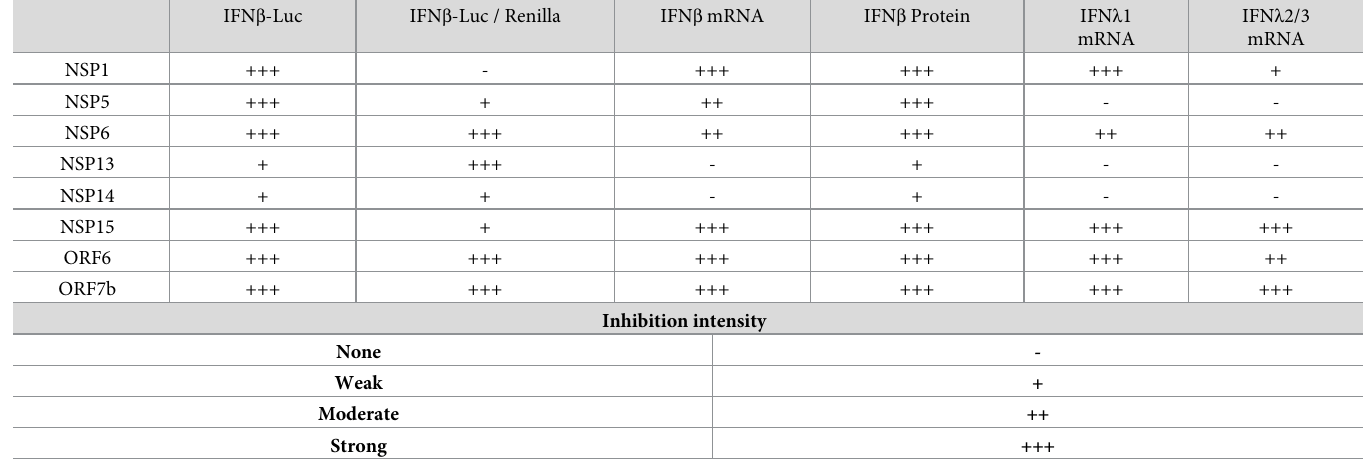
Table 1. Summary of experimental evidence emanating from this study, supporting inhibitory activity of individual SARS-CoV-2 genes in repressing type I and type III IFN production. IFN β